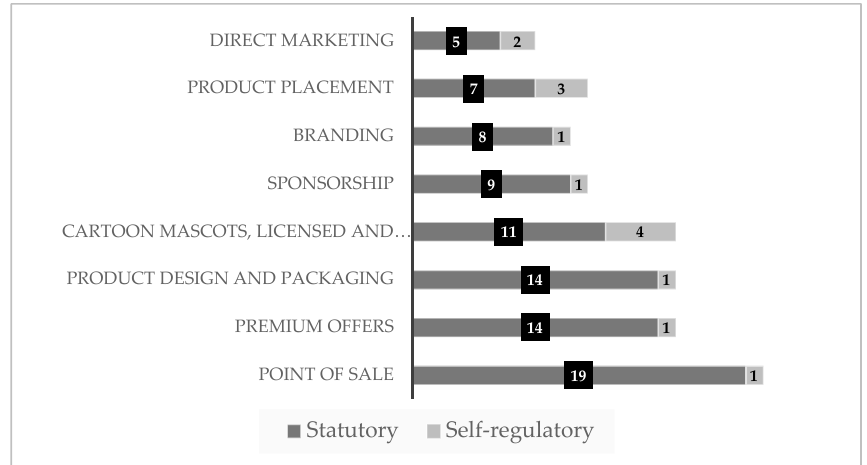
Figure 3. Marketing techniques covered by policies that restrict the marketing of food and beverage products of 14 countries in the Americas Region *. * Data show policy characteristics ( n = 38) of 14 countries of the World Health Organization (WHO) Americas Region, namely, Argentina, Bolivia, Brazil, Canada, Chile, Colombia, Costa Rica, Dominican Republic, Ecuador, El Salvador, Mexico, Peru, Uruguay, and USA.